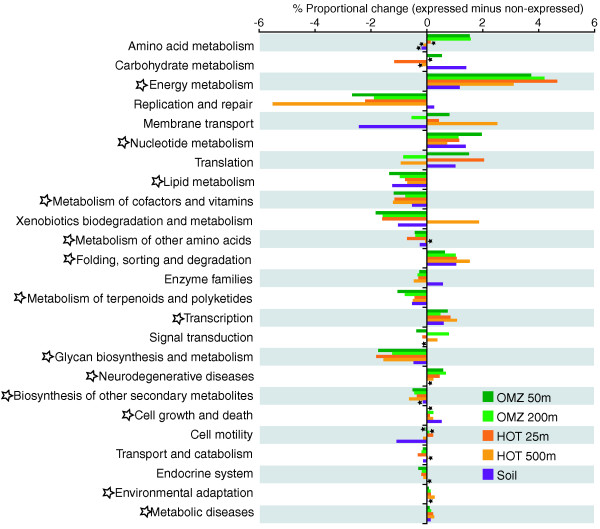
Proportional change in KEGG category abundance between expressed and non-expressed gene fractions. Data are shown for DNA datasets from five representative samples. Unfilled stars mark KEGG k2 categories in which the direction of change was consistent across all five samples. Small filled stars mark categories that did not differ significantly in relative abundance between expressed and non-expressed gene fractions (P > 0.05, chi-square). Only the 25 most abundant KEGG categories are shown.